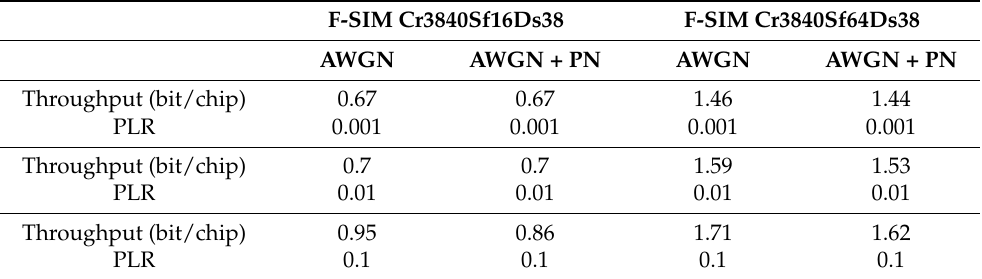
Table 1. UC#1: F-SIM results.